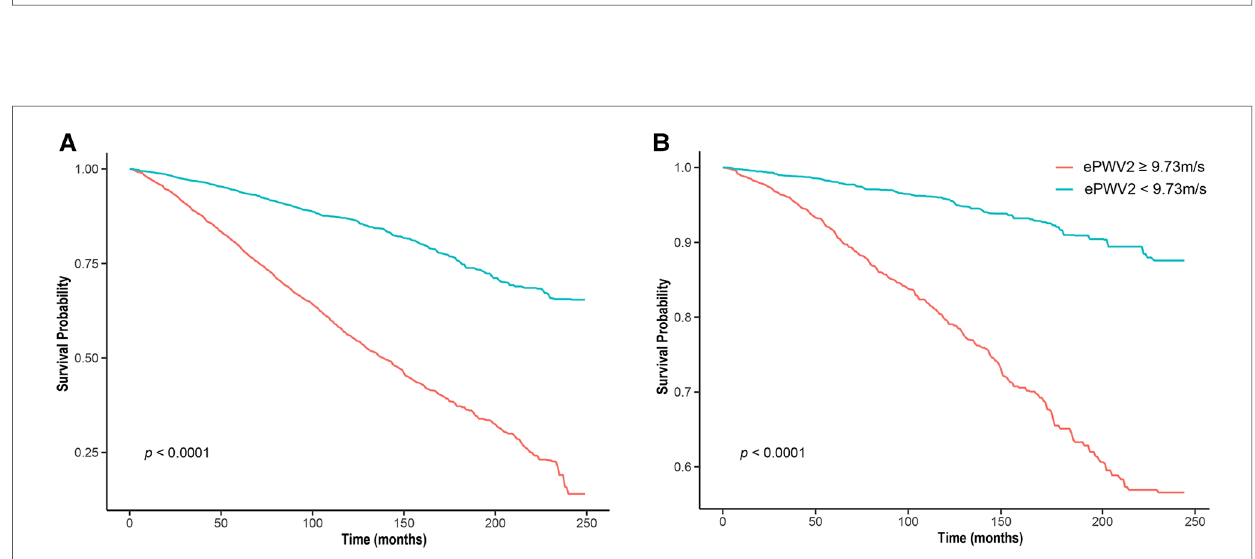
FIGURE 1 The association of ePWV with all-cause ( A ) and cardiovascular mortality ( B ) among participants with diabetes visualized by the restricted cubic spline. HRs were adjusted for sex, race/ethnicity, study circles, education levels, smoking, drinking, hypertension, and CCI. Both p for linearity <0.001. ePWV, estimated pulse wave velocity; CCI, Charlson comorbidity index.